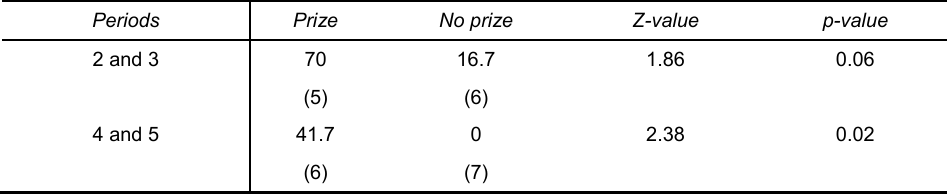
(7) Z-statistics and p-values for the Mann-Whitney U test